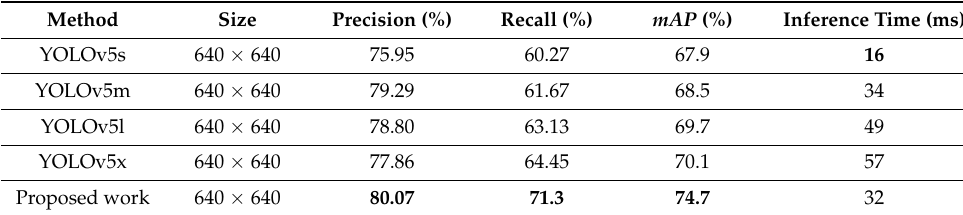
Figure 11. The confusion matrix from the proposed work on the DOTA dataset. Table 2. Accuracy comparison between YOLOv5 series and proposed work.